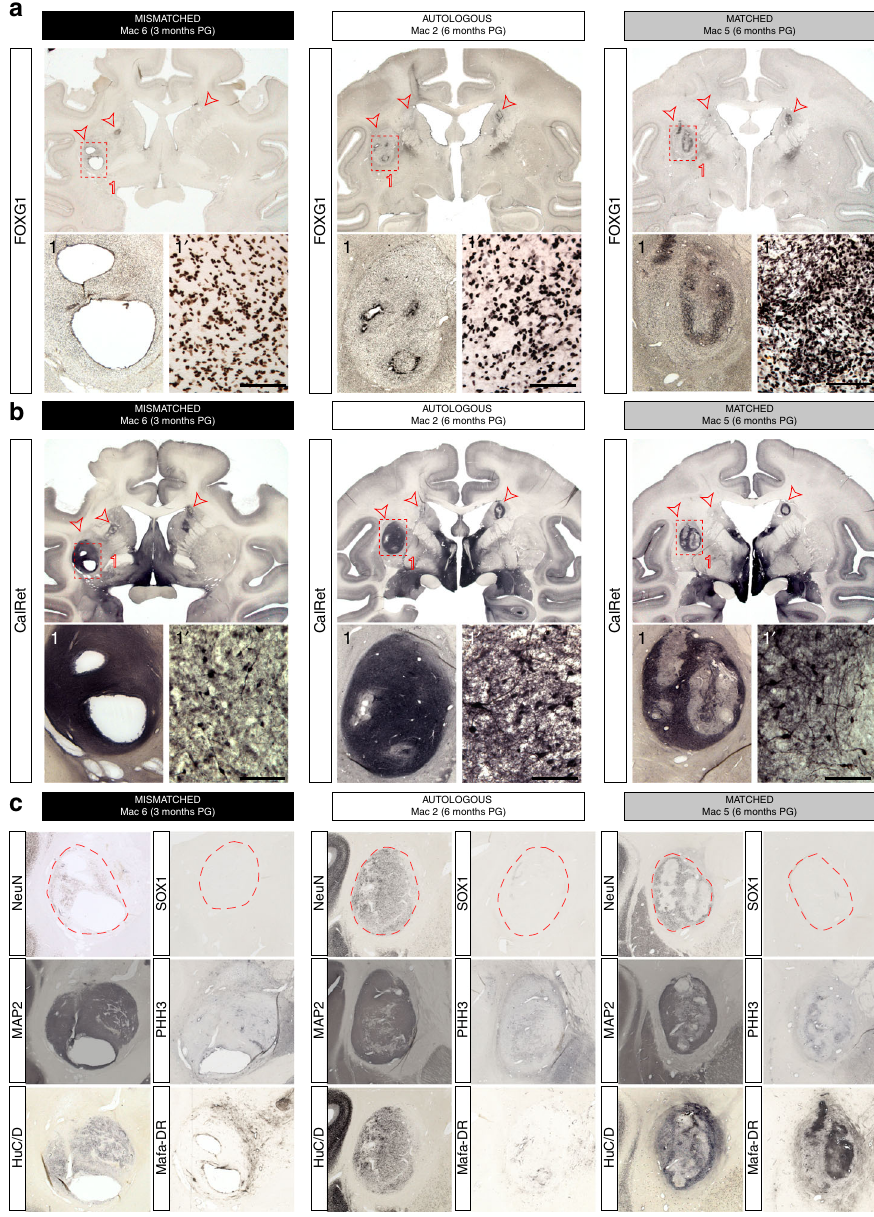
Fig. 5 Histological assessment of graft localization, survival and neuronal identity of the grafts in mismatched (3 months PG), autologous (6 months PG) and matched (6 months PG) NHP recipients. a , b Immunohistological staining of coronal sections of the brain at the level of graft with anti-FOXG1 ( a ) and Calretinin ( b ) antibodies. Red arrows indicate the location of the grafted cells. c Brain slices were stained with post-mitotic neuronal markers NeuN (cell nuclei), MAP2 (soma and neuritic extensions), HuC/D (peri-nuclear soma), SOX1 (immature neural cells), and PHH3 (proliferative cells) compared to Mafa-DR (MHC II). Red dotted lines represent graft contour. Scale bar: 100 µ Genotyping of NHPs . Genomic DNA for all NHP considered was extracted from peripheral blood sample using QIA amp Blood Kit (QIAGEN, Courtaboeuf, France). The animal MHC genotypes were determined with by means of geno- typing 17 microsatellites scattered across the MHC region 14 . Genotypes were determined with DNA Size Standard-kit- 600 (Beckman Coulter, Villepinte, France) after denaturation and separation of the ampli fi cation products by capillary electrophoresis with a CEQ8000 analyzer and scored with the software CEQ8000 Genetic Analysis System v8.0 (Beckman Coulter, Villepinte, France). Primer used to amplify the 18 MHC microsatellites were the following: D6S2972 AAATGTG AGAATAAAGGAGA and GATAAAGGGGAACTACTACA; D6S2970 TCCC